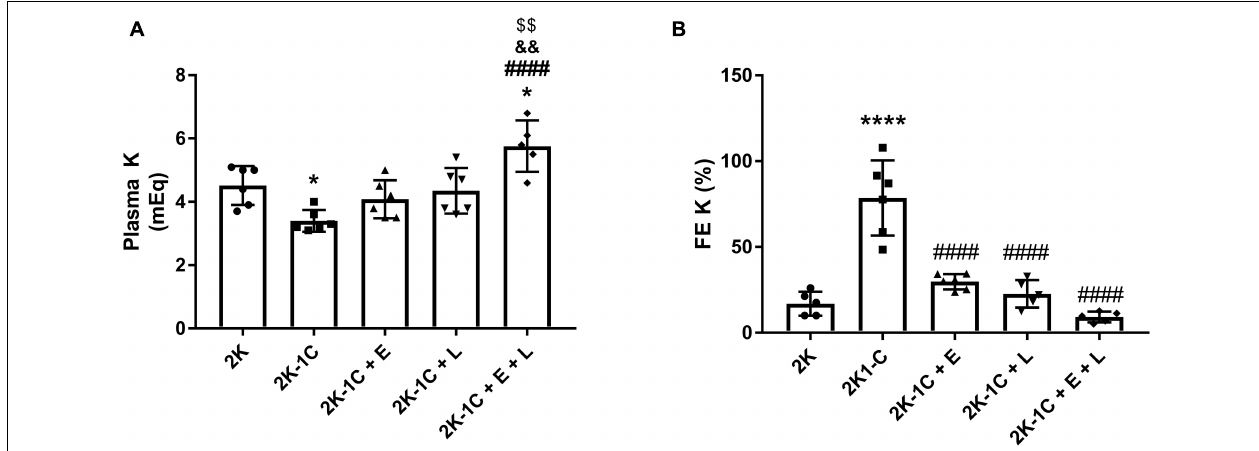
FIGURE 6 | Dual RAS blockade, but not losartan or enalapril alone, induces hyperkalemia in renovascular hypertensive rats. (A) The plasma potassium concentration (Plasma K + ) and (B) the Fractional excretion of potassium (FE K + ) were determined in normotensive (2K) and renal hypertensive (2K-1C) rats treated for 14 days with enalapril (2K-1C + E, 20 mg/kg/day), losartan (2K-1C + L, 30 mg/kg/day), enalapril plus losartan (2K-1C + E + L, 30 and 20 mg/kg/day, respectively), or vehicle (2K and 2K-1C, water: 1 ml/kg). The values represent individual measurements and the means ± SEM. * P < 0.05 and **** P < 0.0001 vs. 2K, #### P < 0.0001 vs. 2K-1C; && P < 0.01 vs. 2K-1C + E; $$ P < 0.01 vs. 2K-1C +